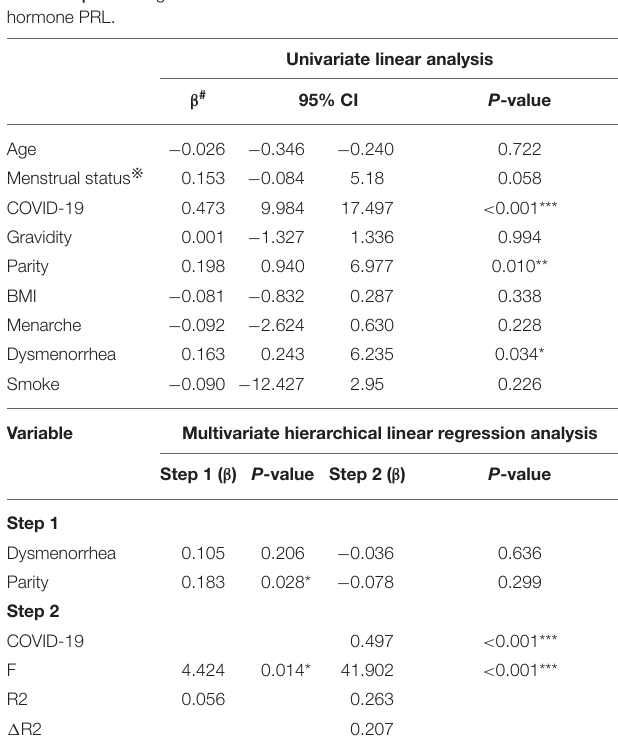
Univariate and multivariate hierarchical linear regression models were used to assess the relationship between COVID-19 clinical characteristics and PRL; Only the variables showing statistical significance in univariate analysis were included in the multivariate hierarchical linear